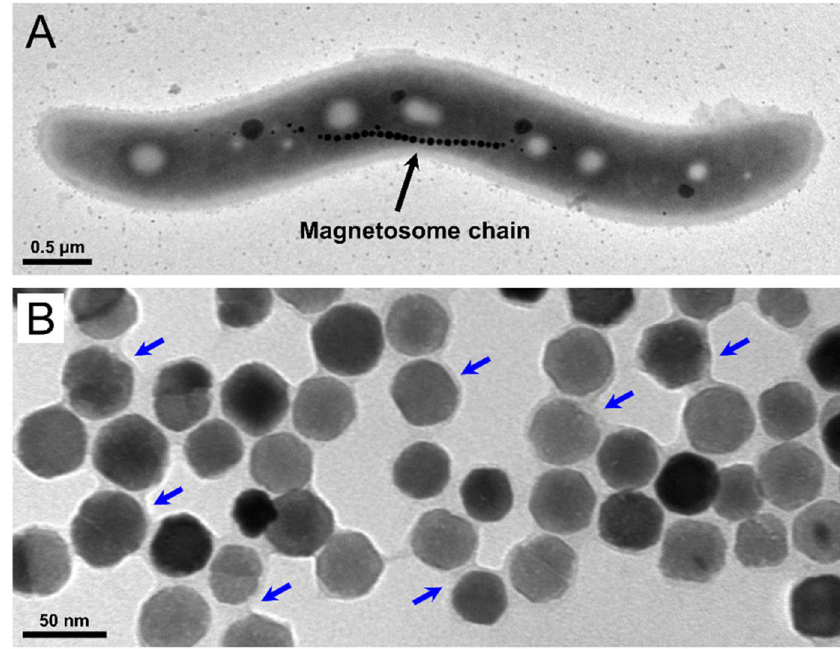
Figure 1. Magnetosomes in M. gryphiswaldense . ( A ) TEM micrograph of a wild-type cell of M. gryphiswaldense . The latter biomineralizes up to 40 magnetosomes, arranged in a chain-like manner at midcell. ( B ) TEM image of a suspension of isolated/purified magnetosomes (negatively stained), containing well-dispersed particles. Magnetosomes consist of a magnetite core that is surrounded by a biological membrane (indicated by arrows). The latter consists of phospholipids and a set of magnetosome-specific proteins, and provides colloidal stability.